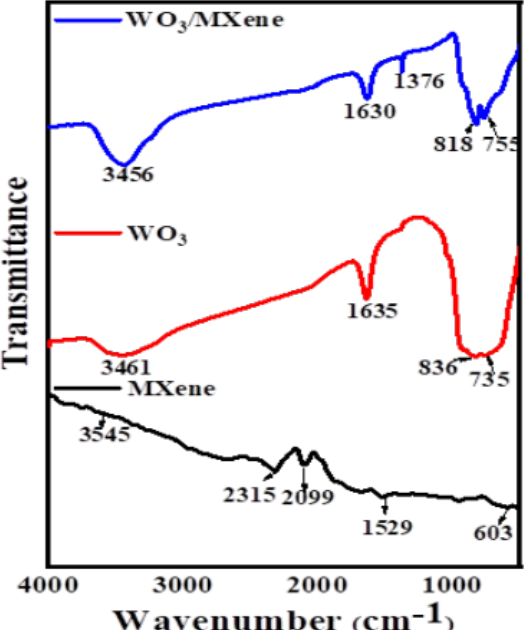
Figure 6. FTIR spectra of MXene, WO 3 , and WO 3 /MXene nanocomposite.